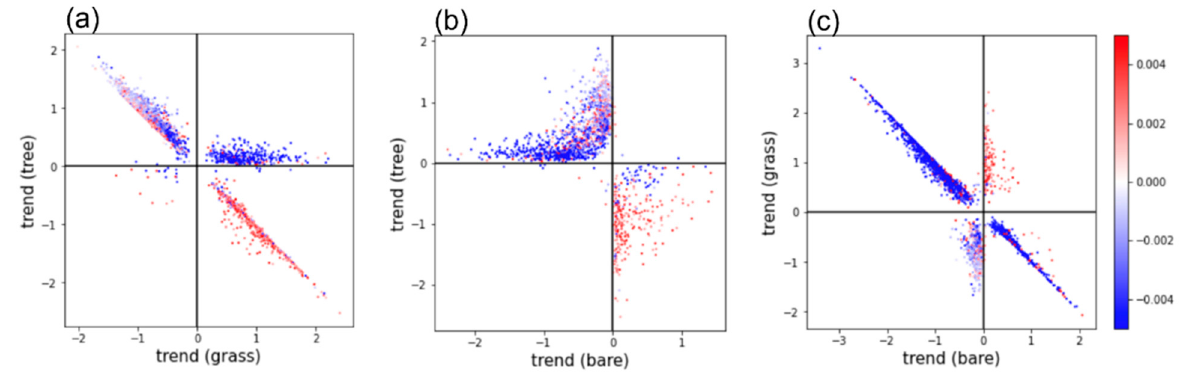
Figure 7. Linear trend of VCF of ( a ) tree canopy and short grassland, ( b ) tree canopy and bare soil, and ( c ) short grass and bare soil from 2003 to 2016. The linear trend of VCF is shown in the x- and y- axis. The color of the dots shows the trend of the b/y index from 2003 to 2016. Only statistically significant trends are depicted.